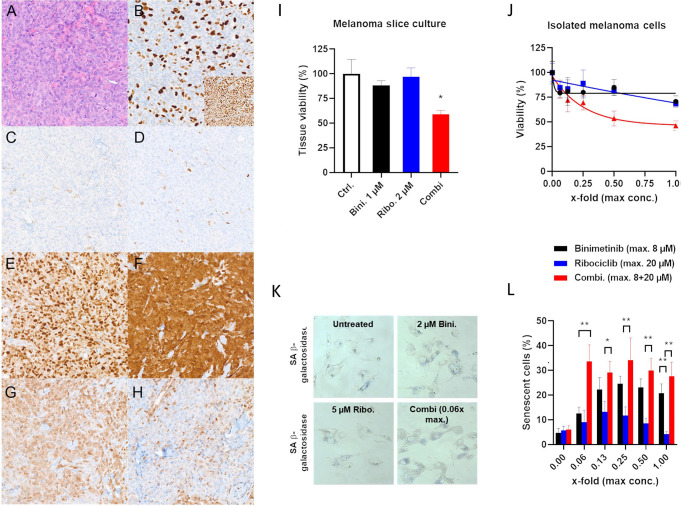
Immunohistochemical panel (A–H). (A) A solid tumor composed of atypical enlarged cells with increased mitotic activity, hematoxylin and eosin staining, 200x original magnification, (B) All cells have preserved retinoblastoma 1 protein (insert), whereas about 30% of RB is phosphorylated (main picture, phospho-RB antibody). (C) The tumor cells show a loss of p16 (only stroma cells are positive) and nearly all cells are negative for p21 (D). (E) Moderate to strong positivity for cyclin D1 in the majority of the tumor cells. (F) Strong and homogenous positivity for CDK6 in all tumor cells. (G) Moderate nuclear and cytoplasmic positivity for phospho-p44/42 MAPK in a vast amount of tumor cells (primarily at the invasive front). (H) weak, primarily cytoplasmic positivity for phosphor-p38 MAPK in a minority of tumor cells (primarily in the invasive front). (B–H) Immunoperoxidase, 200x original magnification). In vitro models used for efficacy testing of binimetinib plus ribociclib (I–L). (I) Alamar blue assay of metastasis slice cultures shows reduced cell viability after combined ribociclib and binimetinib treatment: (mean +/−SD, n=4; *p < 0.05; One-way ANOVA with Sidak’s multiple comparisons test versus untreated controls). (J) Melanoma cells isolated from a patient-derived xenograft tumor generated with tumor cells of the metastasis used in subfigure I show reduced viability after combined ribociclib and binimetinib treatment (alamarBlue assay) (mean +/− SD, n=6). (K, L) Senescence-associated beta-galactosidase of isolated melanoma cells show more intensive staining with combined ribociclib and binimetinib treatment indicating senescence. Percentage of senescent cells is depicted as clear blue cell count normalized to the total cell count (mean +/− SD, n=6, *p < 0.05, **p < 0.01).